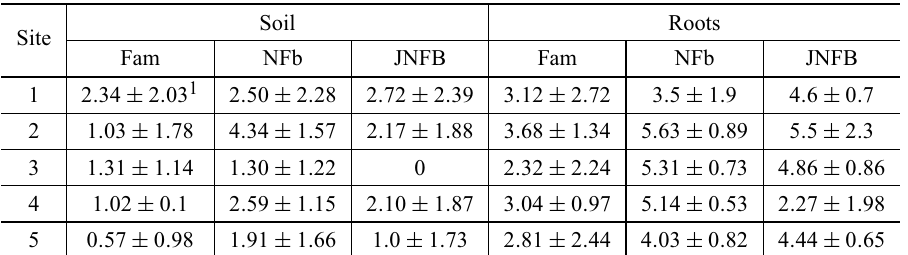
Density (log most probable number g -1 dry soil or fresh roots) of diazotrophic bacteria grown in media: Fam, NFb and JNFB in soil and roots samples collected at different sites of a dumping site of zinc industry.